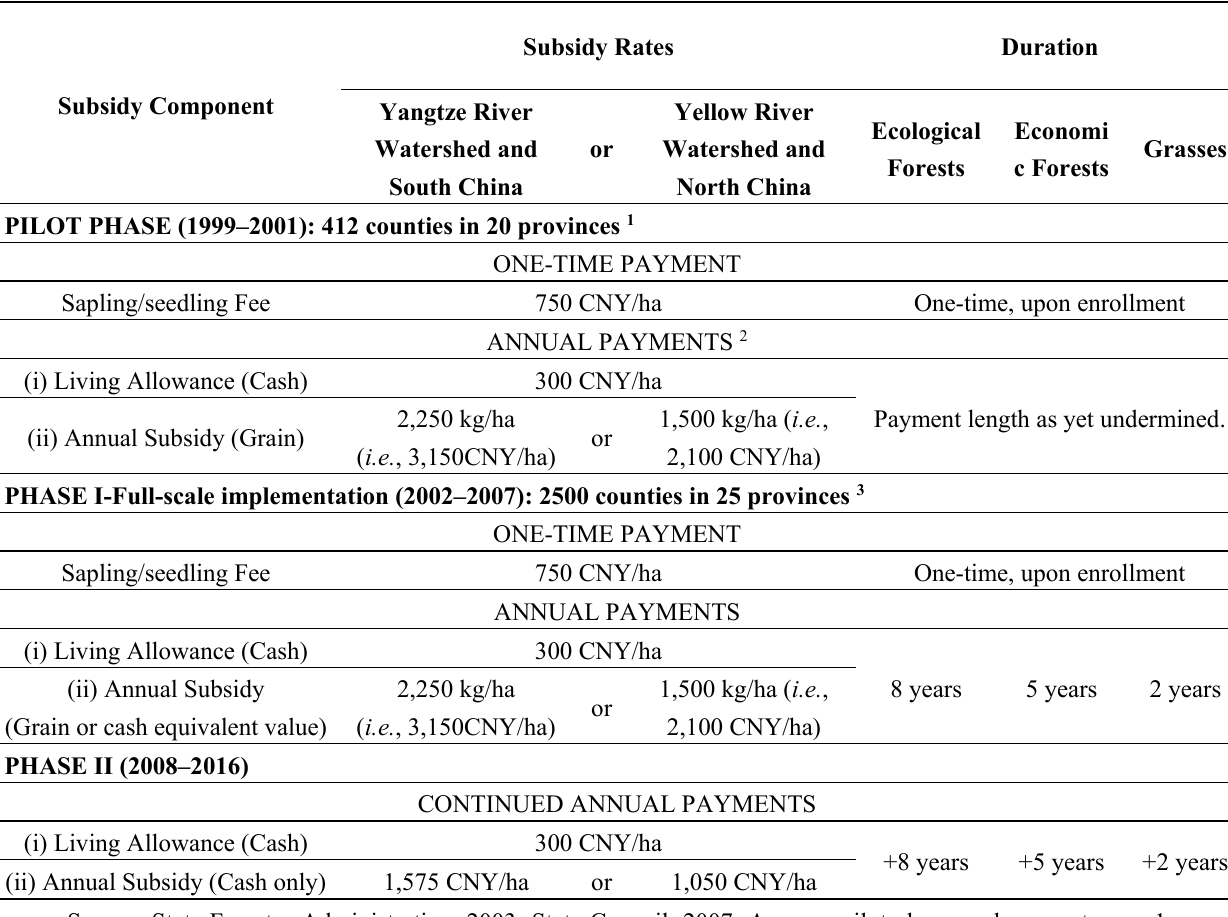
Table 1. The Conversion of Cropland to Forests Program subsidy